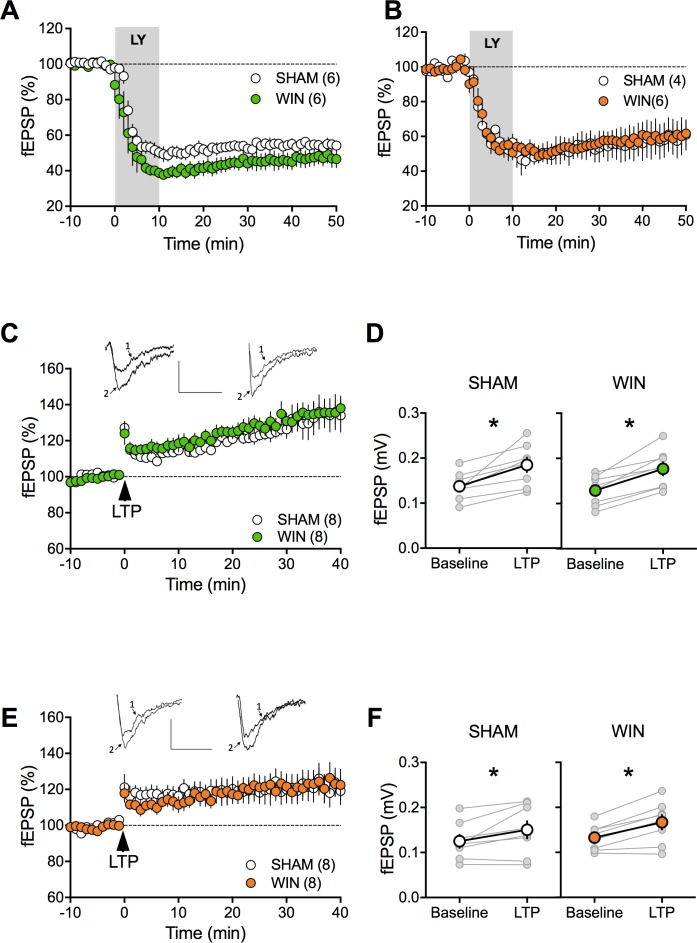
mGlu2/3-LTD and long-term potentiation are spared by prenatal WIN exposure.(A, B) Prenatal exposure to cannabinoids does not alter mGlu2/3-LTD. Average time of mean fEPSPs showing that mGlu2/3-agonist induced LTD (bath application of LY379268, 30 nM, 10 min) is identical in SHAM and WIN exposed male (A): SHAM, n = 6, white circles; WIN, n = 6, green circles) and female (B): SHAM, n = 4, white circles; WIN, n = 6, orange circles). (C) Average time-courses of mean fEPSPs showing that theta burst stimulation (indicated by arrow) induces LTP at layer V/VI mPFC synapses in both SHAM- (white circles, n = 8) and WIN- (green circles, n = 8) exposed male rats. (D) Individual averaged fEPSP amplitude measurements before (baseline) and 40 min after LTP induction. Grey, individual experiments; tan, group averages. In SHAM rats: 0.138 ± 0.011 mV before LTP versus 0.185 ± 0.016 mV after LTP induction (n = 8, p<0.05, paired t-test). In WIN male rats: 0.129 ± 0.012 mV before LTP versus 0.177 ± 0.015 mV after LTP induction (n = 13, p<0.05, paired t-test). (E) Identical TBS-LTP induction protocol but recording from female prenatally-exposed animals (SHAM, white circles, n = 8; WIN, orange circles, n = 8). (F) Peak amplitude measurements before (baseline) and after (LTP) stimulation protocol from individual experiments (grey) and group averages in SHAM (white; 0.125 ± 0.014 mV before LTP versus 0.150 ± 0.020 mV after LTP; p<0.05, paired t-test) and WIN (orange; 0.133 ± 0.010 mV before LTP versus 0.167 ± 0.016 mV after LTP; p<0.05, paired t-test) animals. *p<0.05. n = individual rats. Error bars represent SEM.